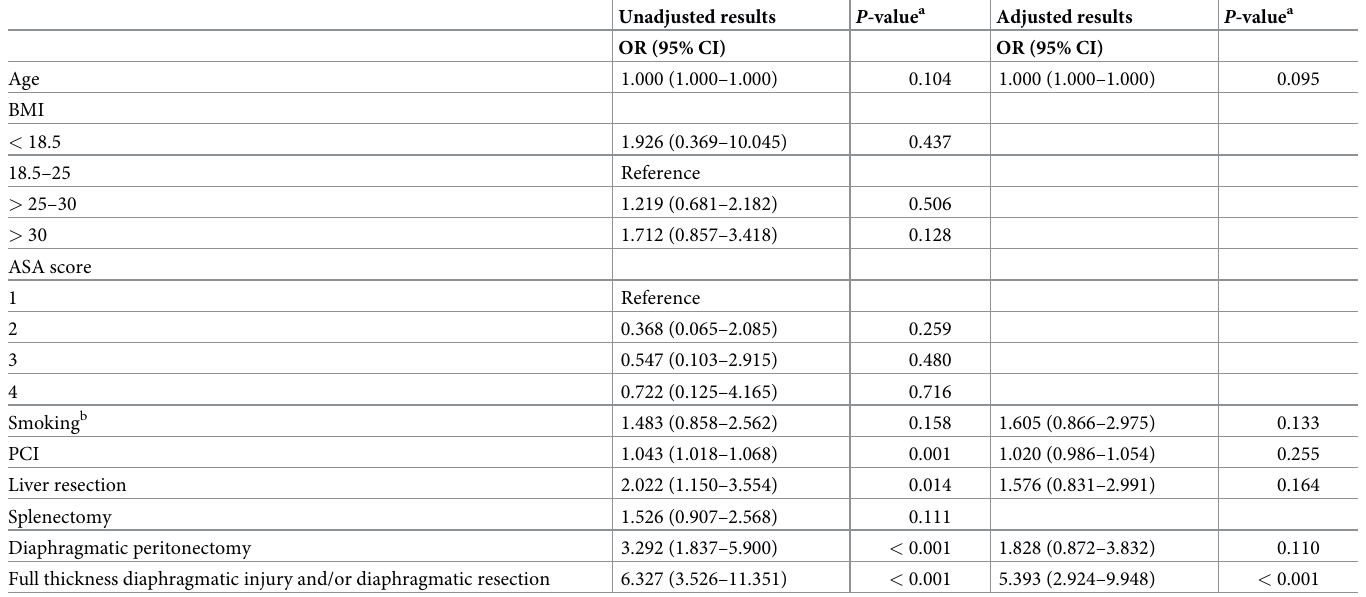
Table 2. Unadjusted and adjusted results of odds ratios and p-values for the variables included in the final model on risk factors for severe pulmonary complica- tions after CRS and